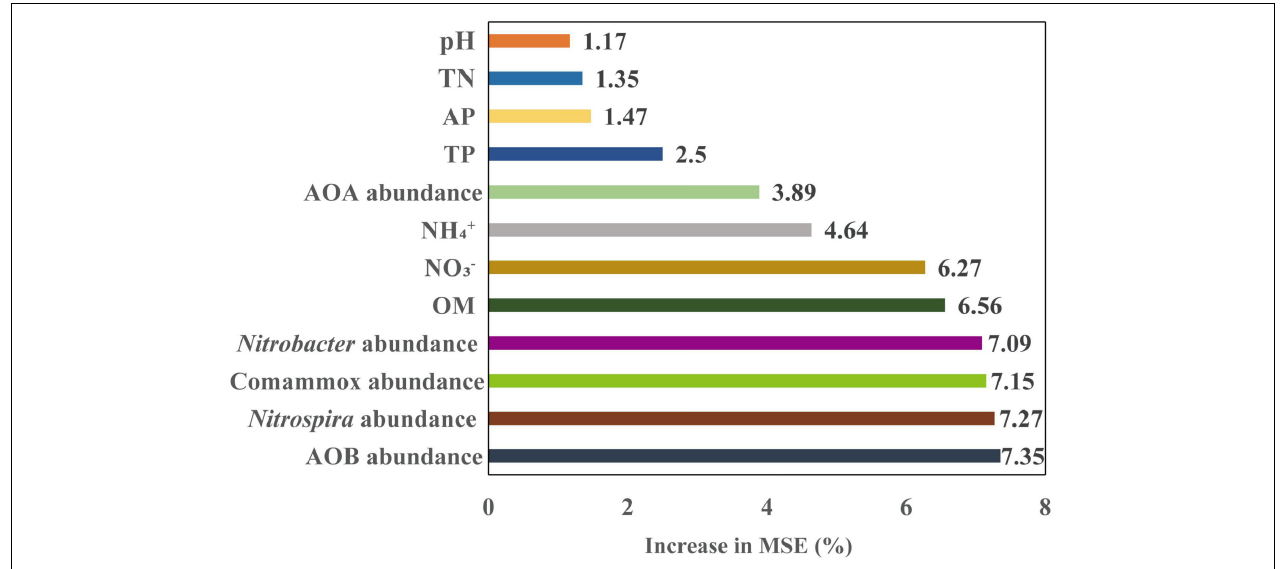
FIGURE 5 | Random forest model predicts the relative importance of soil chemical properties and abundances of nitrifying communities, as measured by percentage of increase in mean square error (MSE) of the potential nitrification rate (PNR). OM, soil organic matter; AP, available P; TP, total P; TN, total N; NO 3 − , nitrate-N; NH 4 + , ammonium-N; AOA, ammonia-oxidizing archaea; AOB, ammonia-oxidizing bacteria; Comammox Nitrospira , complete ammonia oxidizers; Nitrobacter , Nitrobacter -like NOB; Nitrospira , Nitrospira -like